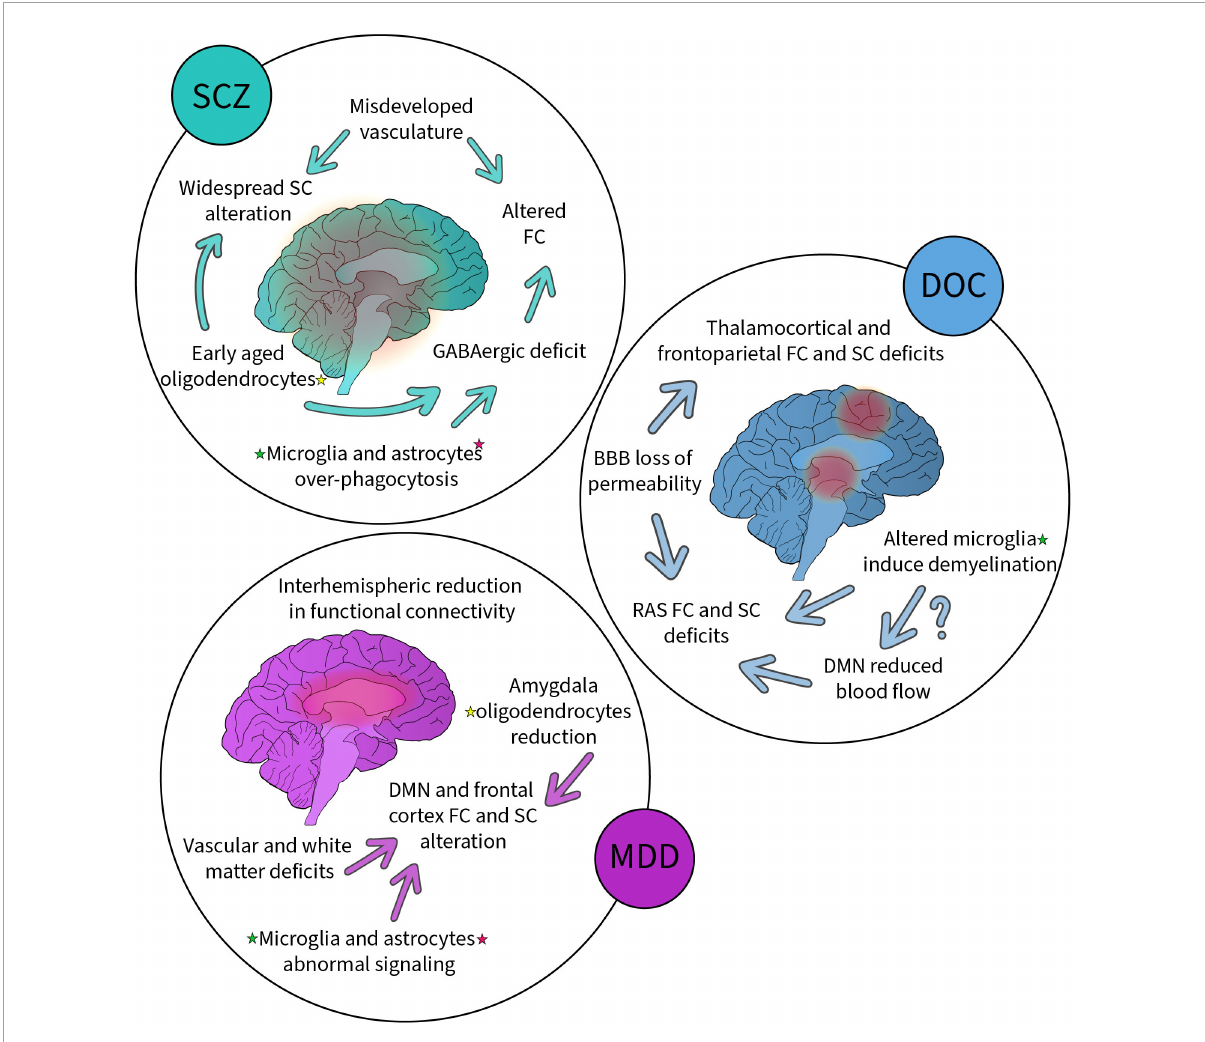
FIGURE2 Summary of the alterations to non-neuronal cells, functional, structural, and vascular networks reported in schizophrenia (SCZ), disorders of consciousness (DOC) and major depressive disorder (MDD). Each disorder has been associated with alterations highlighted here. Some alterations are linked (arrows) suggesting possible causality. Altered non-neuronal cells (highlighted with colored stars, yellow for oligodendrocytes, green for microglia and pink for astrocytes) have been found in all these disorders suggesting their key